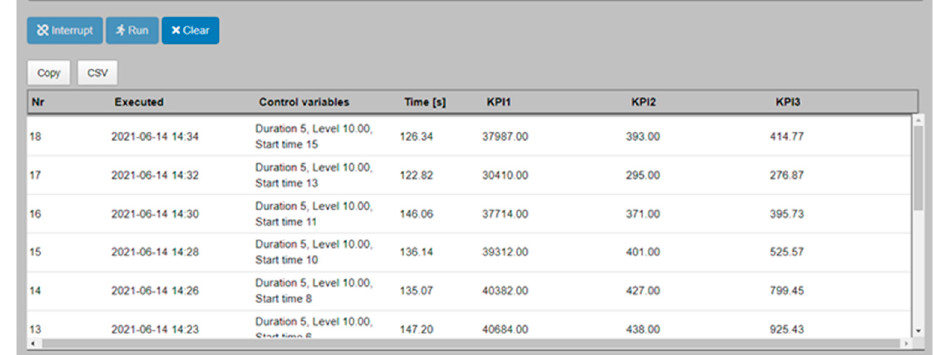
Figure 5. Overview of results in the STP related to RS 1 when changing the attack start time.